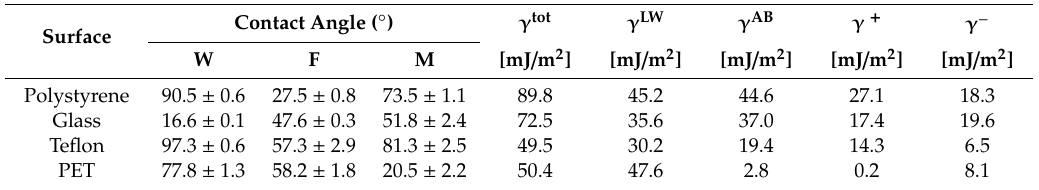
Table 2. Solid surface characteristics—contact angle, total surface free energy values—and their contributions. PET: poly(ethylene terephthalate).